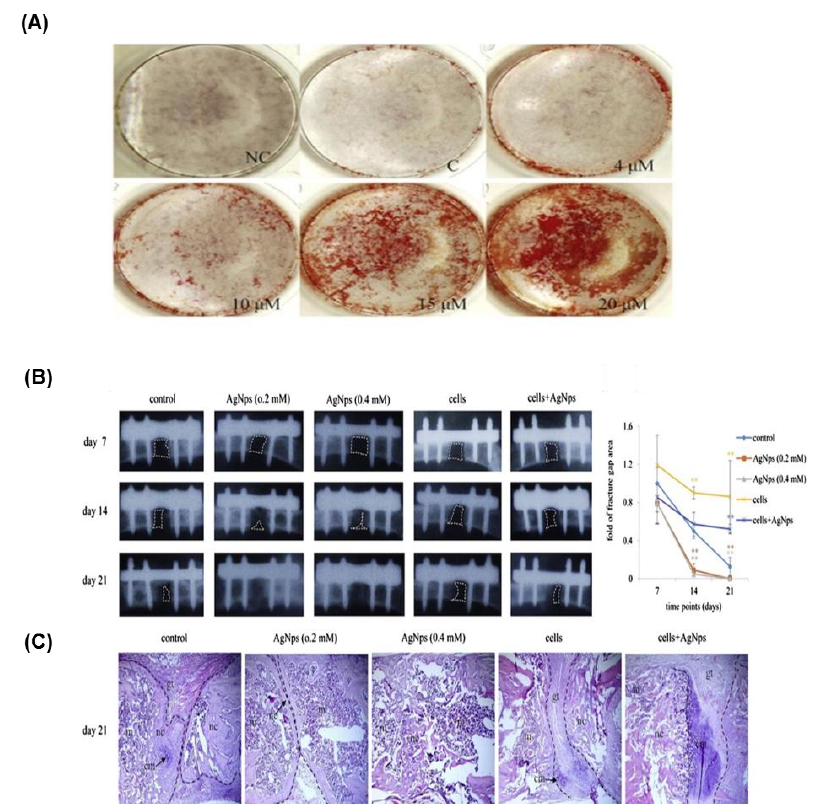
Figure 3. ( A ) AgNPs promoted the osteogenic differentiation of mMSCs in a dose-dependent manner as shown by alizarin red staining. ( B ) The healing of mouse bone fracture after the exposure to AgNPs is highlighted by the plain X-ray radiographic analysis of the location of fracture and the graphic data that represent the fracture gap closure. ( C ) Histological analysis of the fracture site in mice scarified after 21 days was carried out using hematoxylin and eosin staining of the middle section of the fracture. This figure was reproduced from Reference [105] with permission from Elsevier.